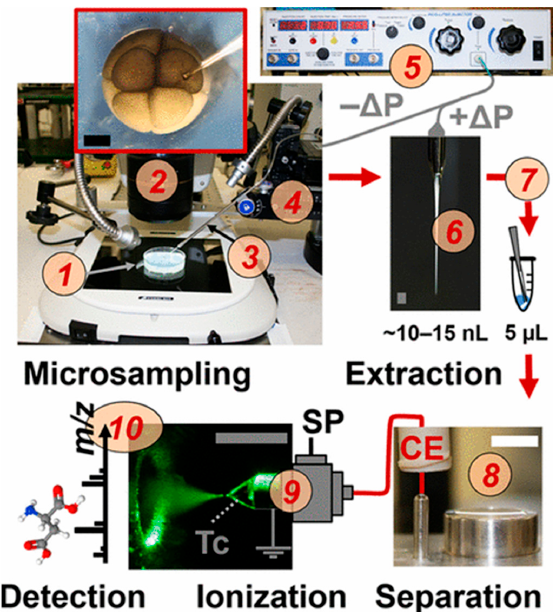
Figure 2. Depiction of in situ single-cell CE-MS with microprobe extraction, including sampling from individual frog embryonic cells, extracting of metabolites at the microscale, and online CE separation coupled to electrospray ionization (ESI)-MS for analysis of differentiating cells in live embryo. The live embryos (1) were identified using a stereomicroscope (2) and 10–15 nL portions were aspirated into a capillary (3) controlled by a multi-axis translation stage (4) coupled to a microinjector that supplied a vacuum (5). Afterwards, the collected cells in the capillary (6) were deposited into a vial via pressure-injection for metabolite extraction (7). After extraction, metabolites were measured with a microloading CE platform (8) and ionized for MS with a CE-ESI source (9). High-resolution tandem MS was used to identify and quantify metabolites (10). Reprinted with permission [7]. Copyright 2018 American Chemical Society.